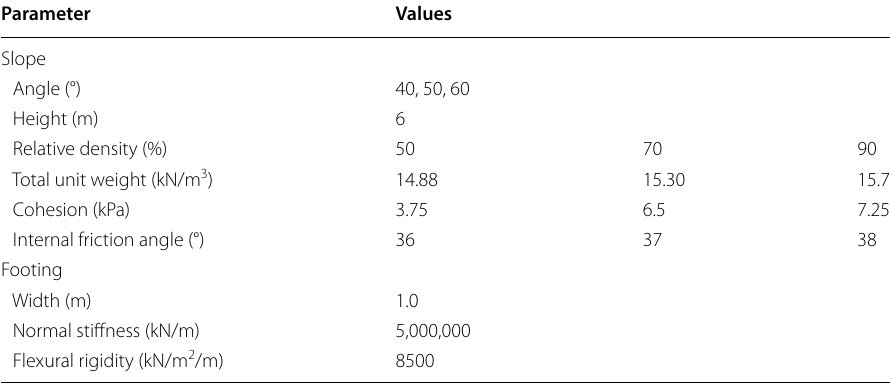
Table 1 Parameters used in the numerical analysis